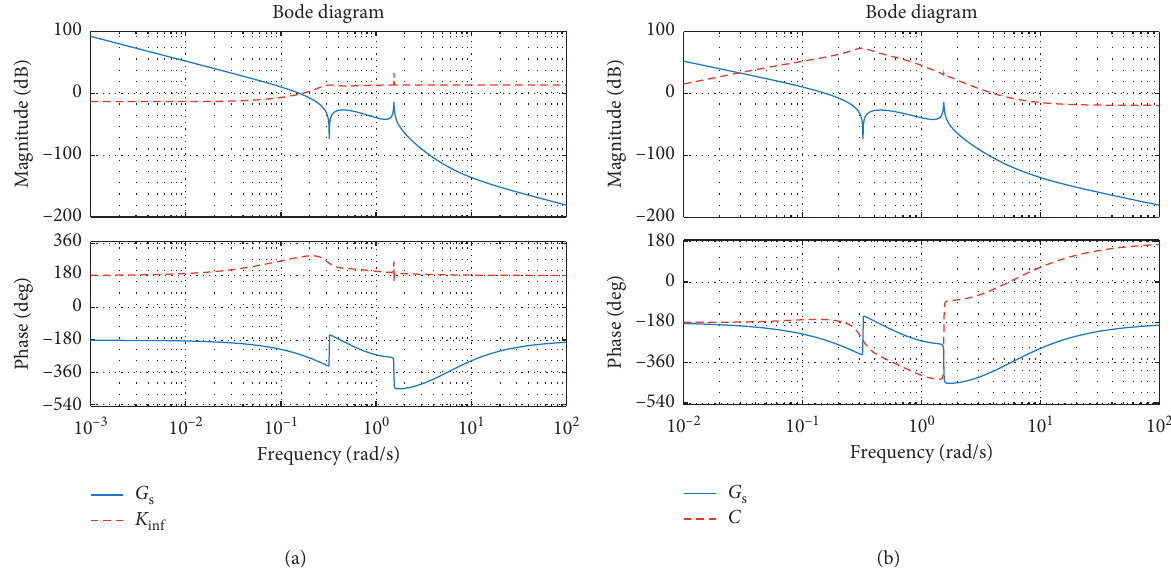
Figure 7: Bode plot based on comparing G